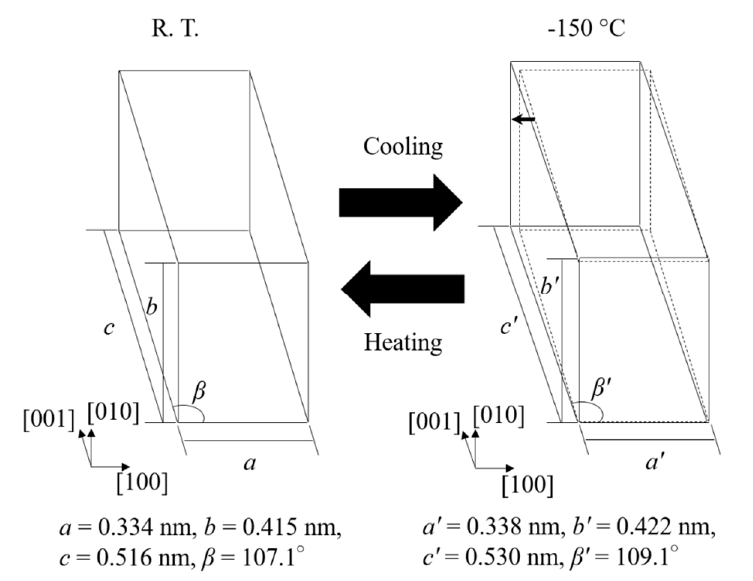
Figure 9. The change of lattice constant in the martensitic phase (R. T.) to the new phase ( − 150 °C) of 10th cycled CuZr alloy.